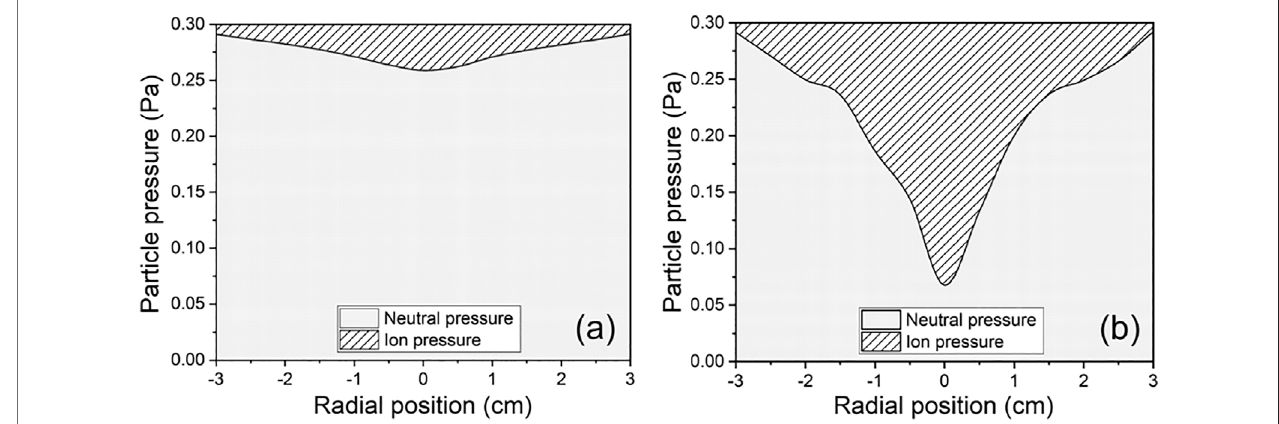
FIGURE 6 | Radial pro fi les of ion pressure and neutral pressure: (A) without blue core, (B) with blue core. Reproduced from [41], with the permission of AIP Publishing.